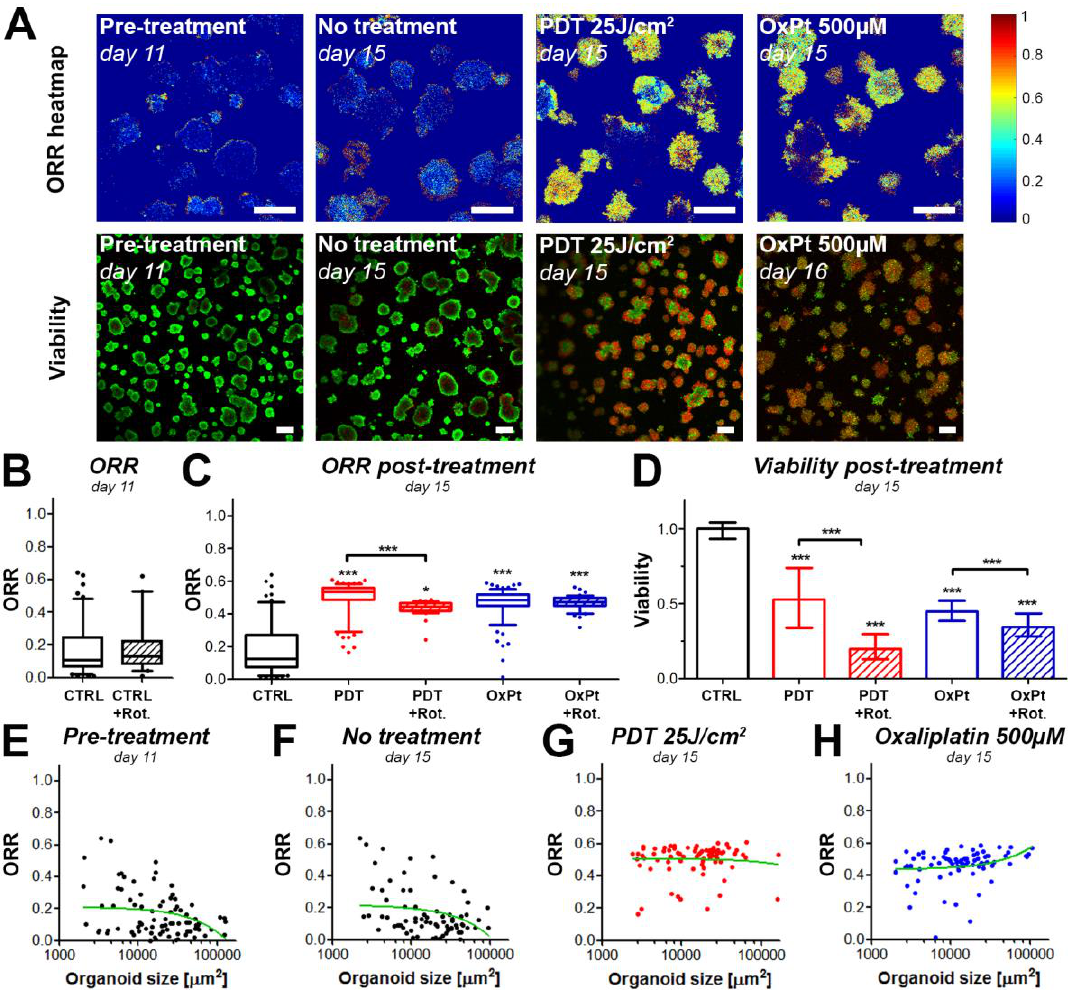
Figure 4. The metabolic redox state in MIA PaCa-2 microtumors changes in response to photodynamic therapy (PDT) and chemotherapy. ( A ) ORR heatmaps and live / dead fluorescence images (live cells in green, dead cells in red) of the same cultures are depicted before and after treatment. Scalebar = 100 µ m. ( B ) The box-whisker plot displays the median, 25th and 75th percentile, and the 90% confidence interval of the microtumor populations. ( C ) Quantification of the ORR of MIA PaCa-2 microtumors post-treatment (PDT or oxaliplatin chemotherapy (OxPt) with or without rotenone (Rot)). The box-whisker plot depicts the median, 25th and 75th percentile, and the 90% confidence interval of the microtumor populations. ( D ) As an auxiliary assay to the ORR determinations, viability of the microtumors was assessed post-treatment. The bars represent the mean ± 95% confidence interval of the microtumor populations. ( E–H ) ORR-size correlations are shown for the microtumors pre-treatment on day 11 ( E ), or on day 15 for the untreated control group ( F ), the 25 J / cm 2 PDT-treated group ( G ), and the 500 µ M oxaliplatin-treated group ( H ). In the scatter plots, the linear regression curve fit (in green) provides a qualitative indication of the size-ORR correlation. Data presented in panels A and E–H are from a single representative experiment, whereas the data plotted in panels B–D were obtained from 2–3 technical repeats with N = 3 wells containing ~700 individual microtumors / well. * p ≤ 0.05, *** , p ≤ 0.005.